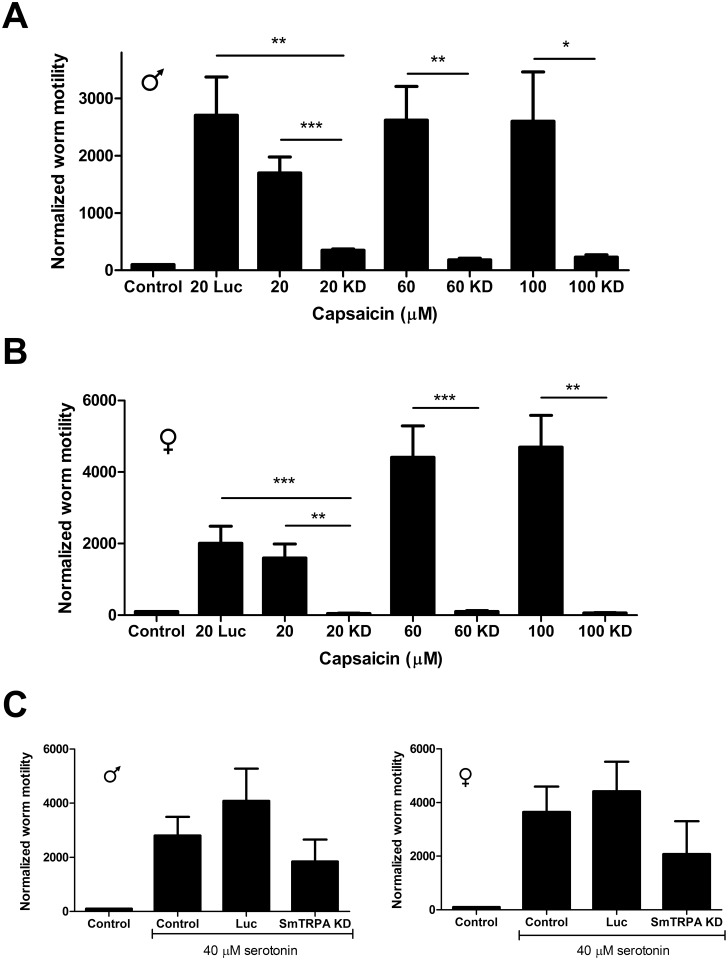
Knockdown of SmTRPA eliminates schistosome response to capsaicin.Comparison of capsaicin-dependent worm motility between normal adult worms (eg, no electroporation or knockdown) and those electroporated with 5 μg SmTRPA siRNA (KD). (A) Male worms. (B) Female worms. Capsaicin concentrations are shown. Those bars labeled with only the capsaicin concentration (20, 60, 100) on the X axis designate normalized motility following exposure to that concentration of capsaicin in worms that have not been subjected to knockdown. Those showing the capsaicin concentration plus "KD" (20 KD, 60 KD, 100 KD) designate capsaicin-induced normalized motility in worms subjected to knockdown of SmTRPA. Also shown are "Control" worms (no knockdown, no capsaicin) and worms electroporated with 5 μg luciferase siRNA (Luc) and exposed to 20 μM capsaicin as a control for effects of electroporation with siRNA. Worm activity was assessed as in Fig 1. *, **, ***, P<0.05, P<0.01, P<0.001 respectively, unpaired t-test vs. control worms for each capsaicin concentration. n = 5–10. C. Knockdown of SmTRPA (SmTRPA KD) has no significant effect on response of adult males (left) or females (right) to 40 μM serotonin. "Control", "Luc" labels are the same as in A and B. n = 4–6.